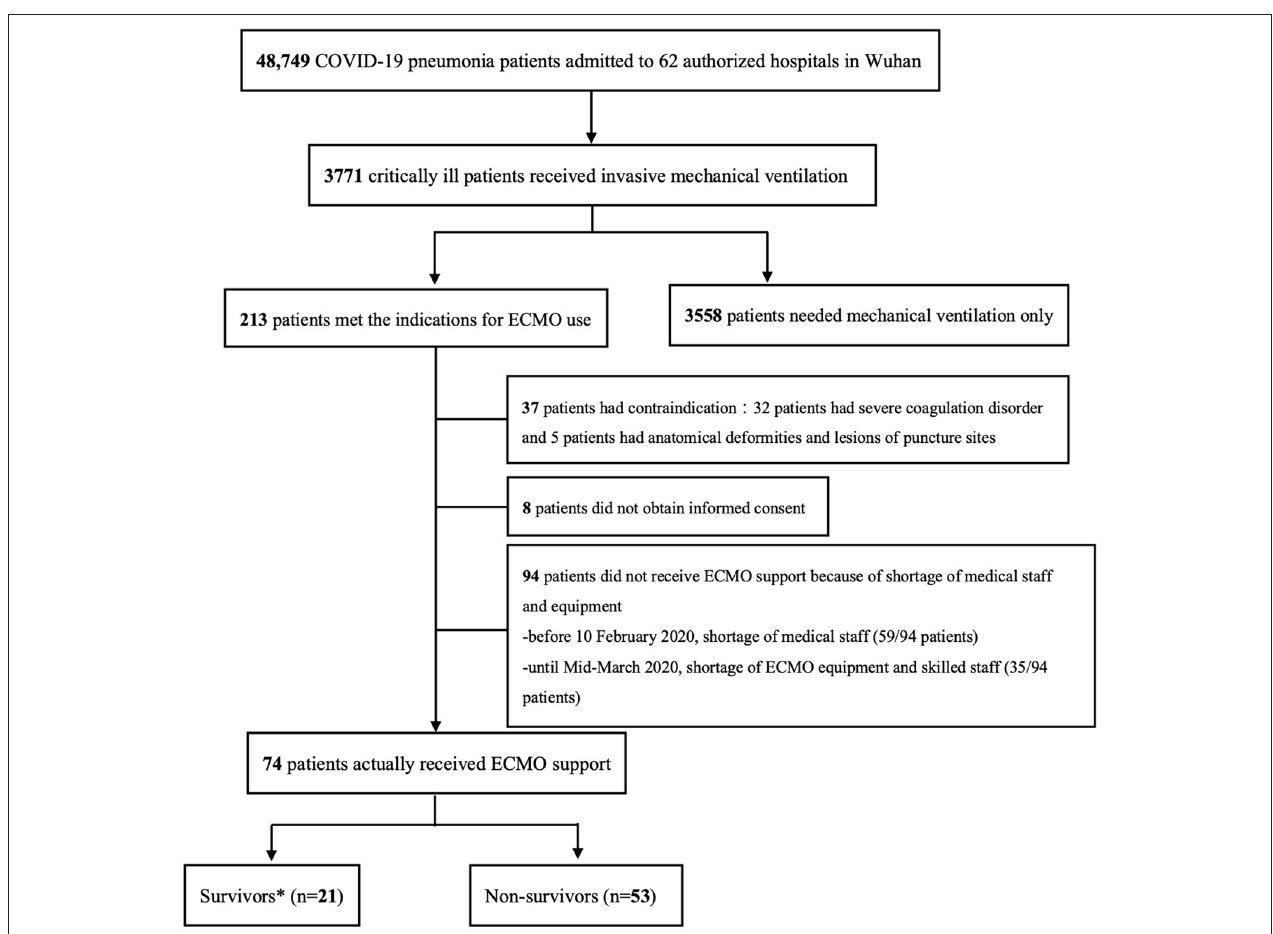
FIGURE 1 | Enrollment Flowchart. *Survivors and non-survivors were divided according to in-hospital mortality.